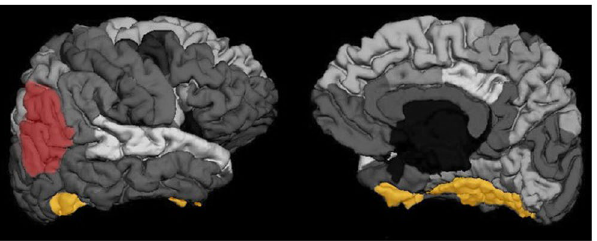
Figure 6. Highlighted cortical areas according to the Desikan-Killiany Atlas whose roughness difference distinguished between control and ET conditions. Yellow area’s roughness also differenciated the two ET groups derived from the rule model. Left: lateral surface of the rigth hemisphere; Right: medial surface of the right hemisphere.